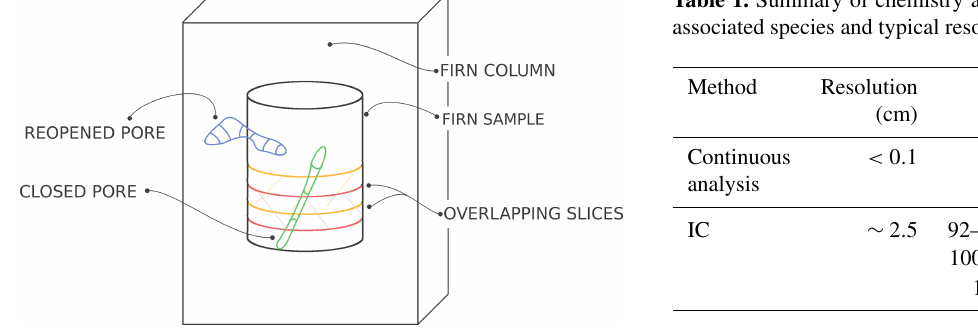
Figure 1. Depiction of a cylindrical firn sample, numerical slices in tomographic images, and pores. The yellow and orange slices represent two overlapping slices. The blue pore illustrates the cut- bubble effect: a pore initially closed in the firn column appears open in the cylindrical sample. The green pore is fully enclosed in the cylindrical sample and is thus considered closed in the slices even if it intersects with their boundaries.